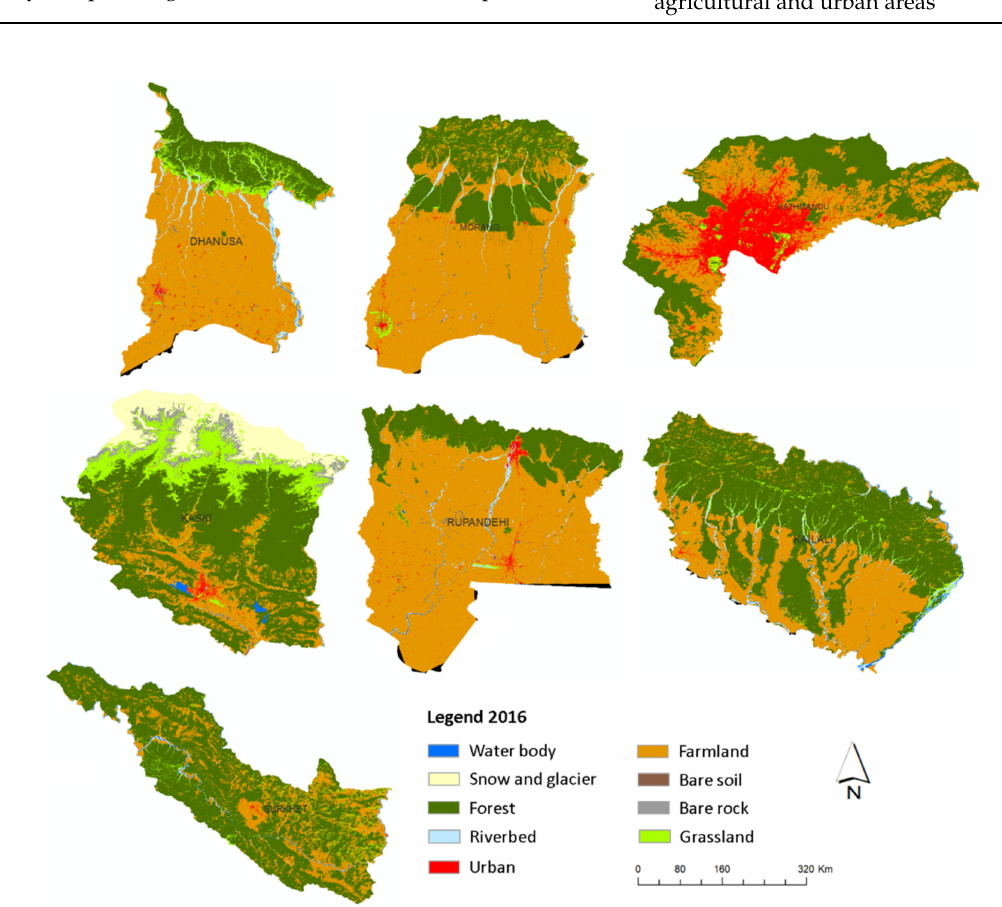
Figure 2. Land cover of the seven interest districts in